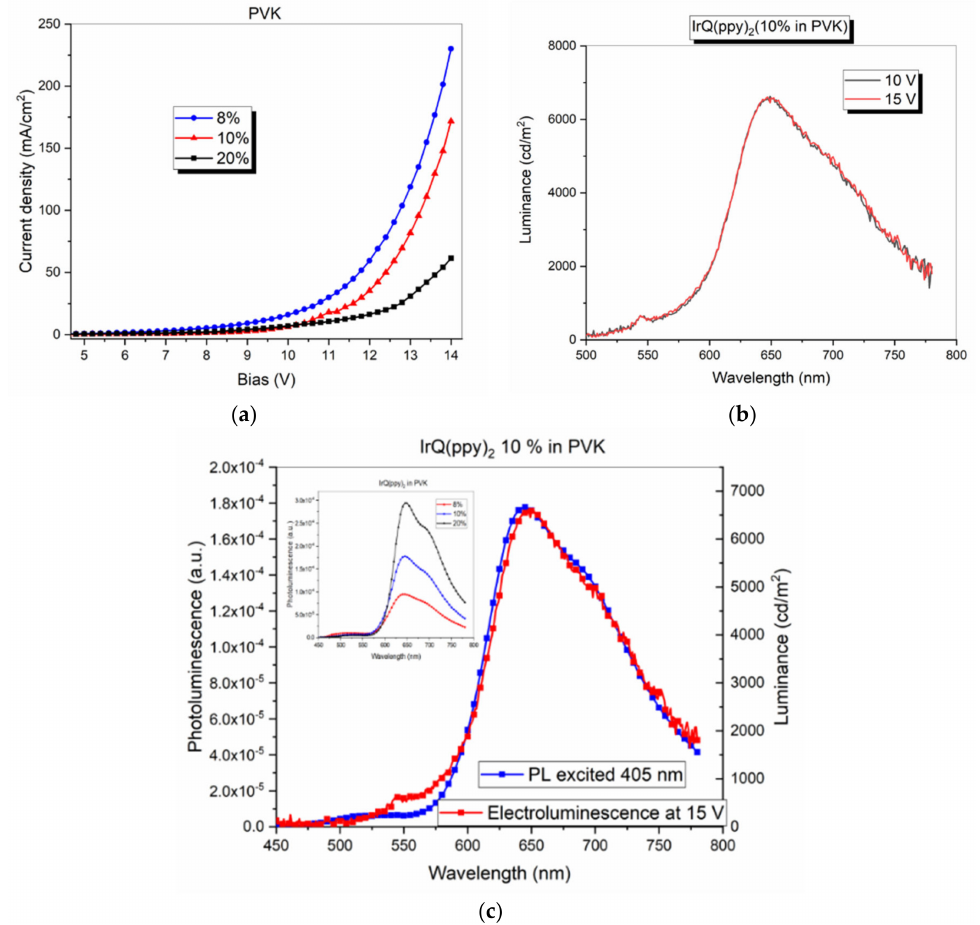
Figure 3. ( a ). Current–voltage of IrQ(ppy) 2 based OLED in PVK versus concentrations; ( b ) luminance versus applied bias for the 10% IrQ(ppy) 2 in PVK; ( c ) luminance and photoluminescence of the IrQ(ppy) 2 (10%) in PVK.